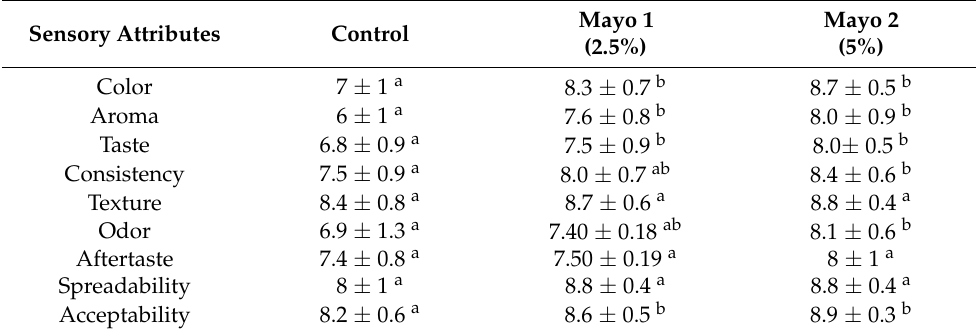
Table 9. Sensory attributes values given by the panelists to sauces: Control = mayonnaise without the addition of powder; Mayo 1 and Mayo 2 = mayonnaise with 2.5 and 5% powder of sea buckthorn